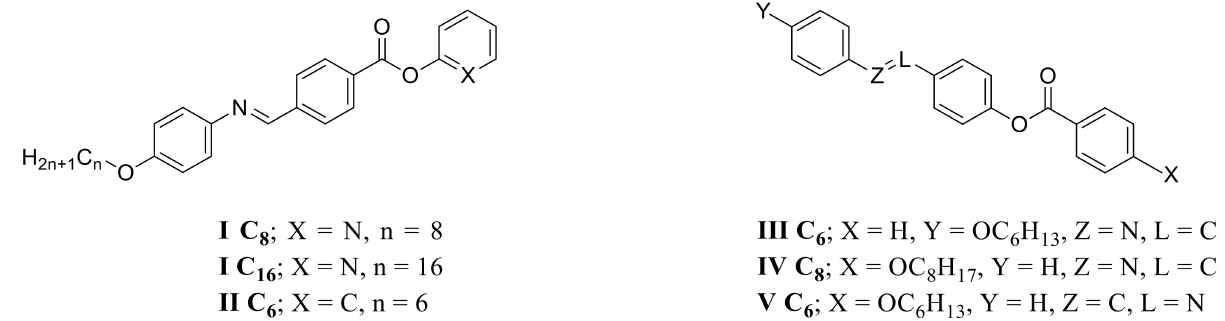
Figure 1. The structures of investigated compounds I C 8 , I C 16 , II C 6 , III C 6 , IV C 8 , and V C 6